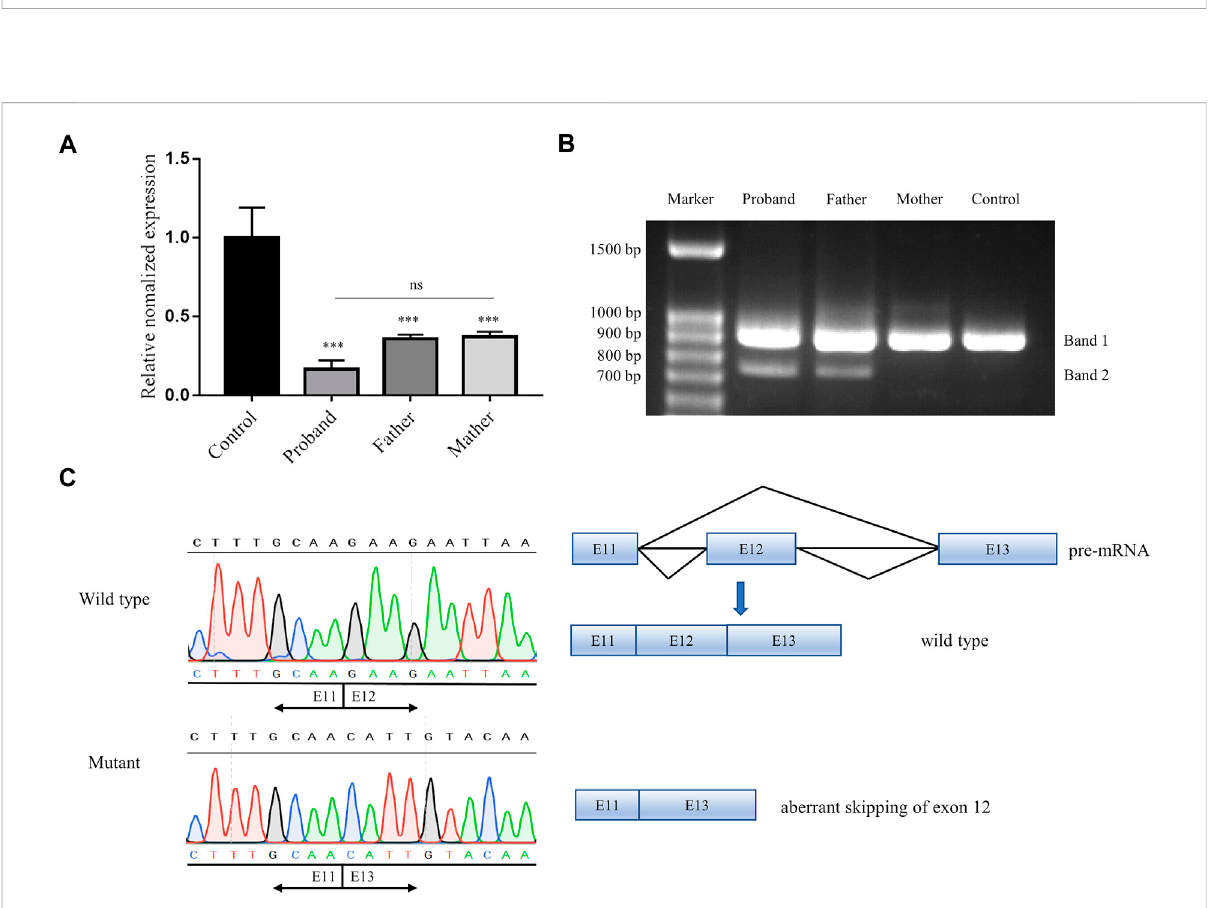
FIGURE 3 Pathogenicity veri fi cation of a novel splice-site variant in our study. (A) qPCR result showed the relative expression of CEP152 of the proband and his parents to be 16.6%, 36.0%, and 37.3%, respectively. *** p < 0.001 ( t -test). (B) Agarose gel electrophoresis showed that spanning exon ampli fi cationproductsintheprobandandhisfather,whoalsocarriedthesplice-sitevariant,werecomparedwithhismotherandthehealthycontrol individual. All subjects displayed a common 907-bp band (band 1, wild type), while the proband and his father had an additional 743-bp band (band2,mutant). (C) LefthalfisSangersequencingshowingthe743-bpbanddeletedexon12(164bpnucleotidesof CEP152 cDNA)comparedtothe 907-bp band (matching to the reference sequence). The right half is the schematic representation of the normal and aberrant